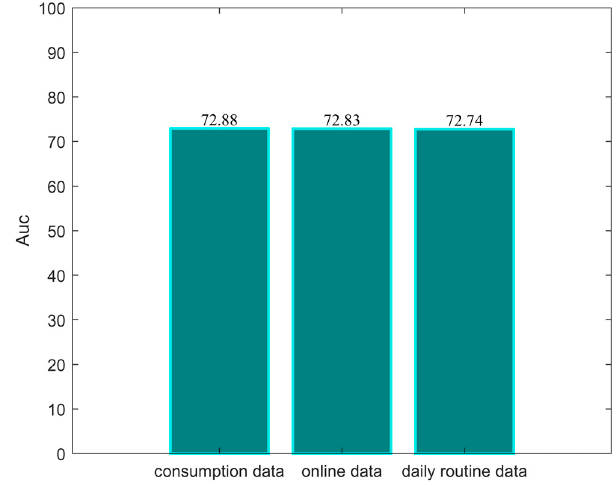
Figure 6. Test accuracy of the TSIN on different student behavior sets.